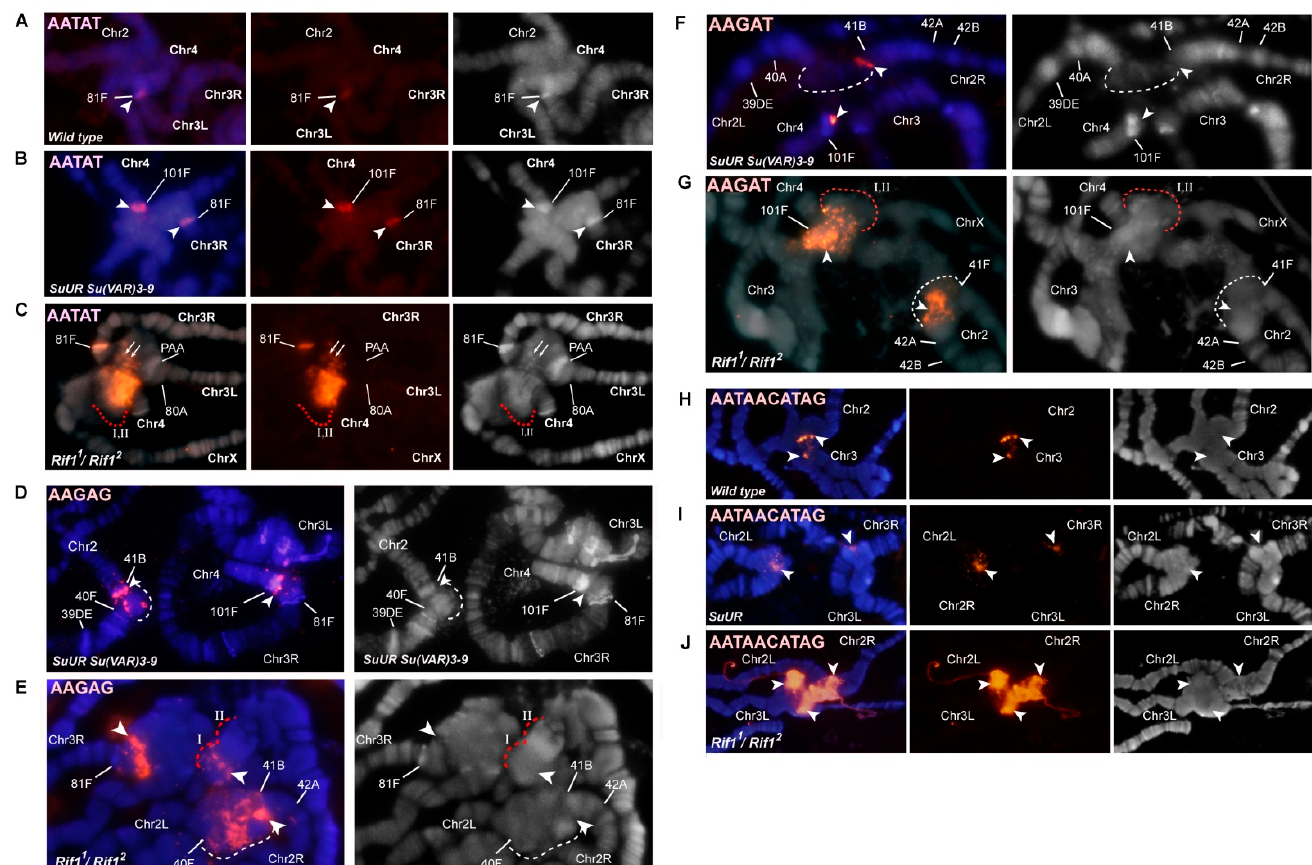
Figure 3. Comparison of the effects of mutations Rif1 1 /Rif1 2 and SuUR ES Su(var)3-9 06 on polytenization of simple satellites. In situ hybridization of DNA probes specific to satellites AATAT ( A – C ), AAGAG ( D , E ), AAGAT ( F , G ) or AATAACATAG (Prodsat) onto polytene chromosomes of wild-type larvae ( A , H ) and mutants SuUR ES Su(var)3-9 06 ( B , D , F , I ) and Rif1 1 / Rif1 2 ( C , E , G , J ). No signal was detected in wild-type polytene chromosomes with the probes to AATAG and AAGAT satellites under the same hybridization conditions (data not shown). White dashed lines indicate the β -heterochromatin of chromosome 2 and red dashed lines indicate zones II and II at the base of chromosome 4. The left column is a superposition of the hybridization signal and DAPI staining, the right column is the DAPI staining, and the central column in ( A ) is the hybridization signal.